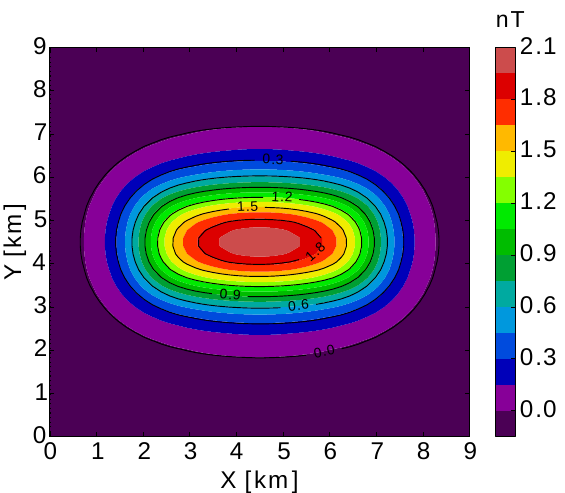
Figure 15. Initial (colour map) and inverted (contour lines) magnetic response for the T model.